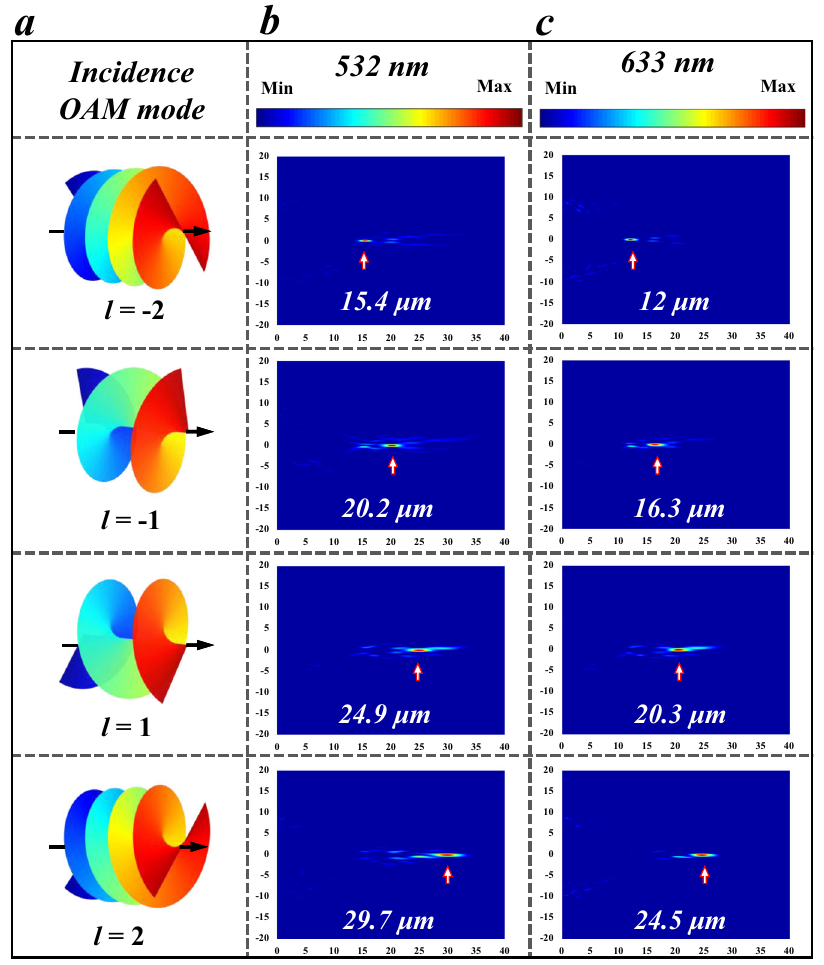
Fig. 2 | Simulation results for varifocal VDM of different incidence modes and wavelengths. a From up to down are the schematics of the vortex phase dis- tribution with topological charge of − 2, − 1, 1, and 2, in sequence. The light fi eld